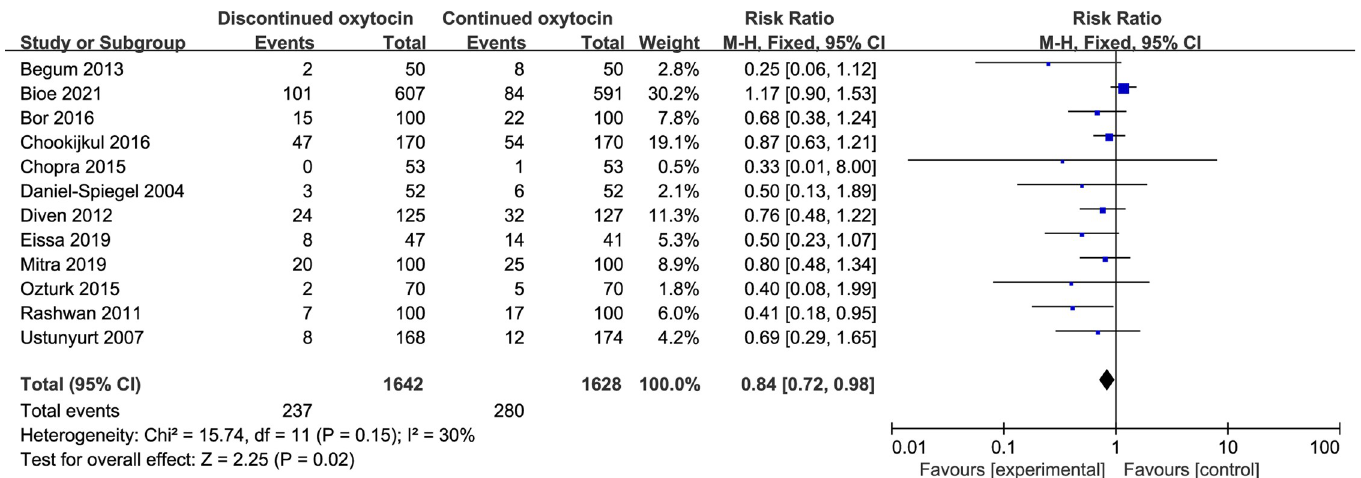
Fig 5. Pooled results for each outcome.